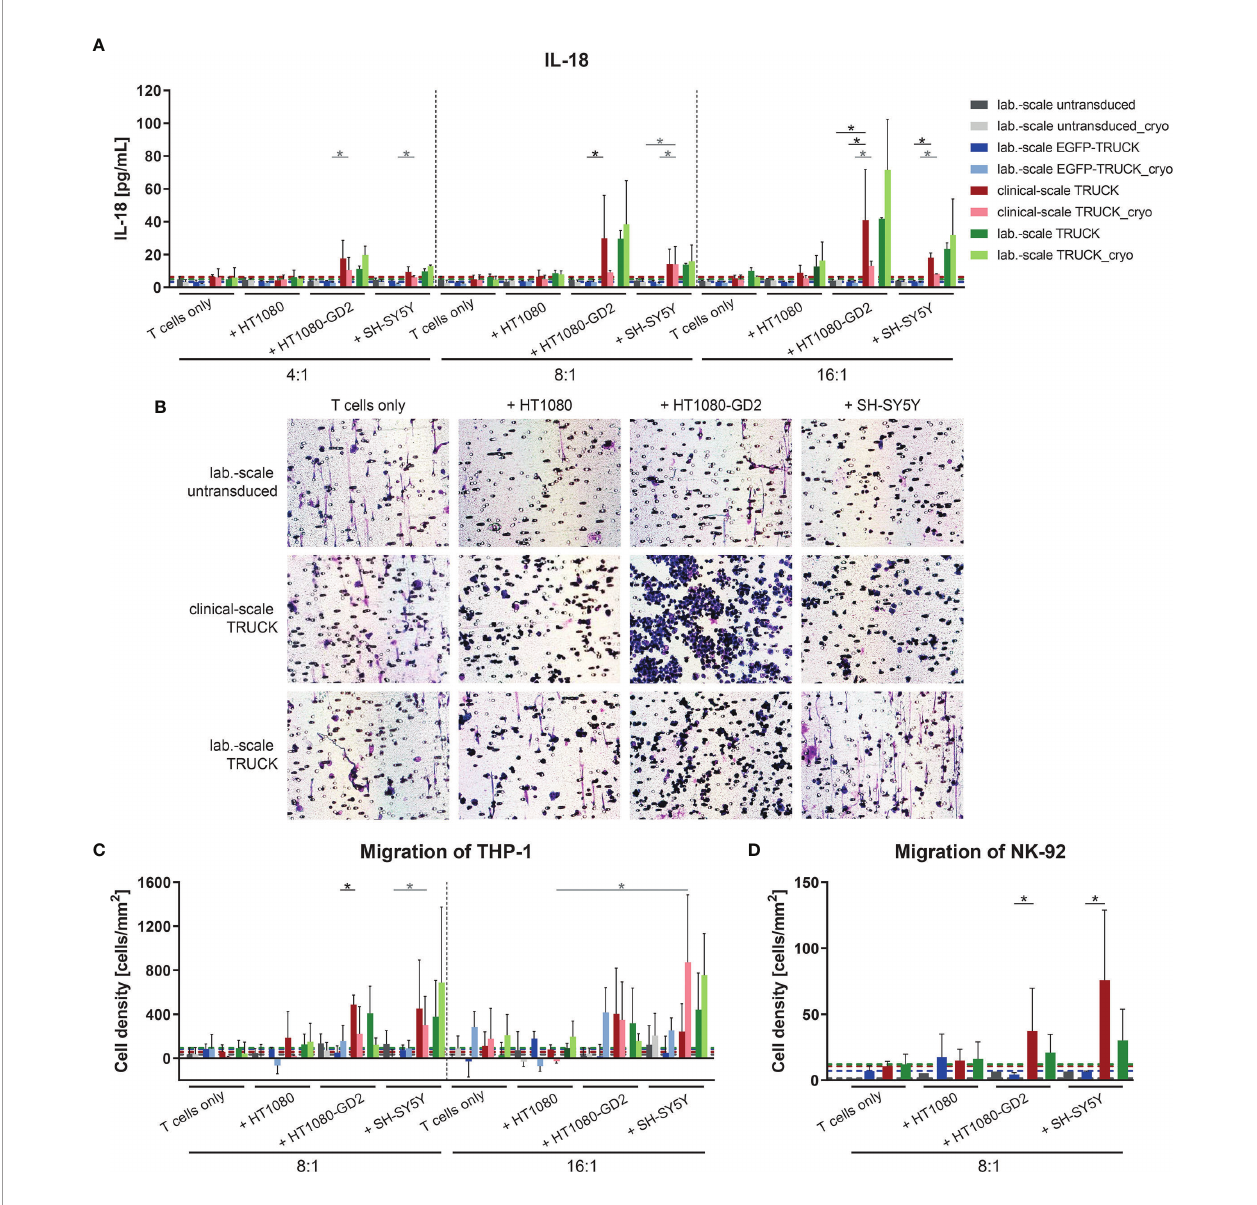
FIGURE 7 | Clinical-scale-manufactured IL-18 TRUCKs targeting GD 2 released IL-18 in a target-speci fi c manner leading to innate immune cell attraction. IL-18 TRUCKs targeting GD 2 were generated using the CliniMACS Prodigy ® (clinical-scale TRUCK; n=2) or under laboratory conditions (lab.-scale TRUCK; n=3). Untransduced T cells (lab-scale untransduced; n=3) as well as GD 2 TRUCKs with inducible EGFP expression (EGFP-TRUCK; n=3 [except for D, in which n=1]) served as control. The manufactured cells were tested for functionality either directly after the generation process (d12) or after cryopreservation and thawing (cryo) by co-cultivation with the indicated target cells in the indicated effector-to-target (E:T) ratios or cultivation alone (T cells only). (A) The concentration of released cytokines in the cell culture supernatants after 48h was assessed by LEGENDPlex ™ . The chemoattractive potential of IL-18 released by TRUCKs upon target recognition in terms of the migration of (B, C) THP-1 and (D) NK-92 cells was assessed. Supernatant of engineered T cells cultured alone (T cells only) or together with the indicated target cells for 48 h was placed in a Boyden chamber, covered with an 8 µm polycarbonate membrane and incubated for another 4h. Medium served as the control supernatant. Cells migrated through the membranes were Giemsa stained. (B) Representative pictures of Giemsa stained THP-1 cells (violet) on the bottom of the membrane. (C, D) The number of cells that migrated through the membrane was determined. To normalize results from different plates, cell numbers of migrated cells towards untransduced T cells only were subtracted from all values. (A, C, D) Data is shown as mean ± SD. A dashed line indicates background levels of the respective cytokine release by untransduced T cells (grey), EGFP-TRUCKs (blue), as well as clinical-scale (red) and laboratory-scale (green) TRUCKs cultured alone. Statistical differences of large-scale TRUCKs co-cultured with different target cells after generation or cryopreservation as well as in comparison to laboratory-scale manufactured cells were assessed by Kruskal-Wallis and Dunn ’ s test, signi fi cant differences are shown (*p ≤